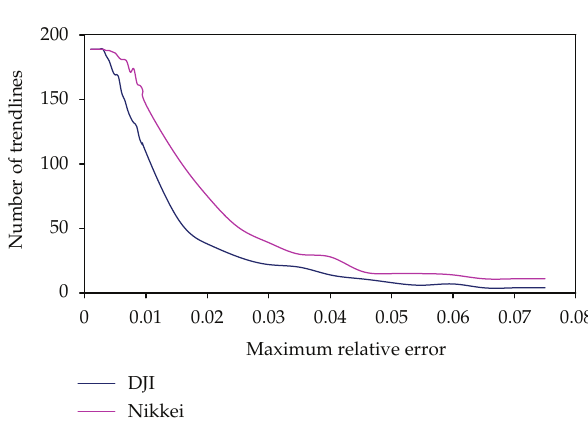
Figure 3: Number of trendlines N w versus 0 . 001 (cid:2) ε (cid:2) 0 . 06 for the Dow Jones and Nikkei